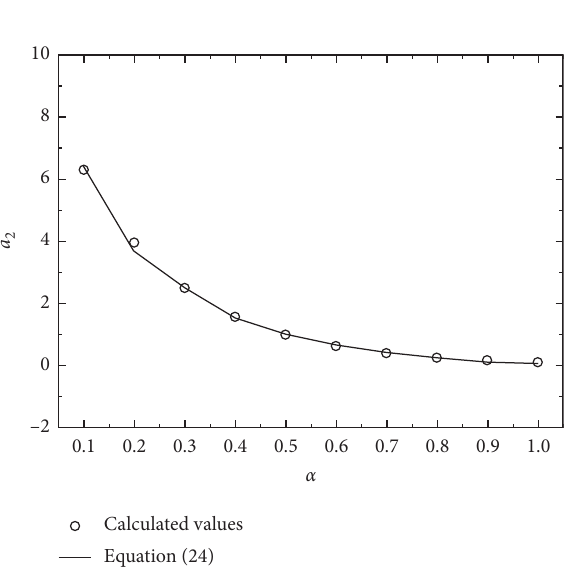
Figure 8: Fitting curve of a